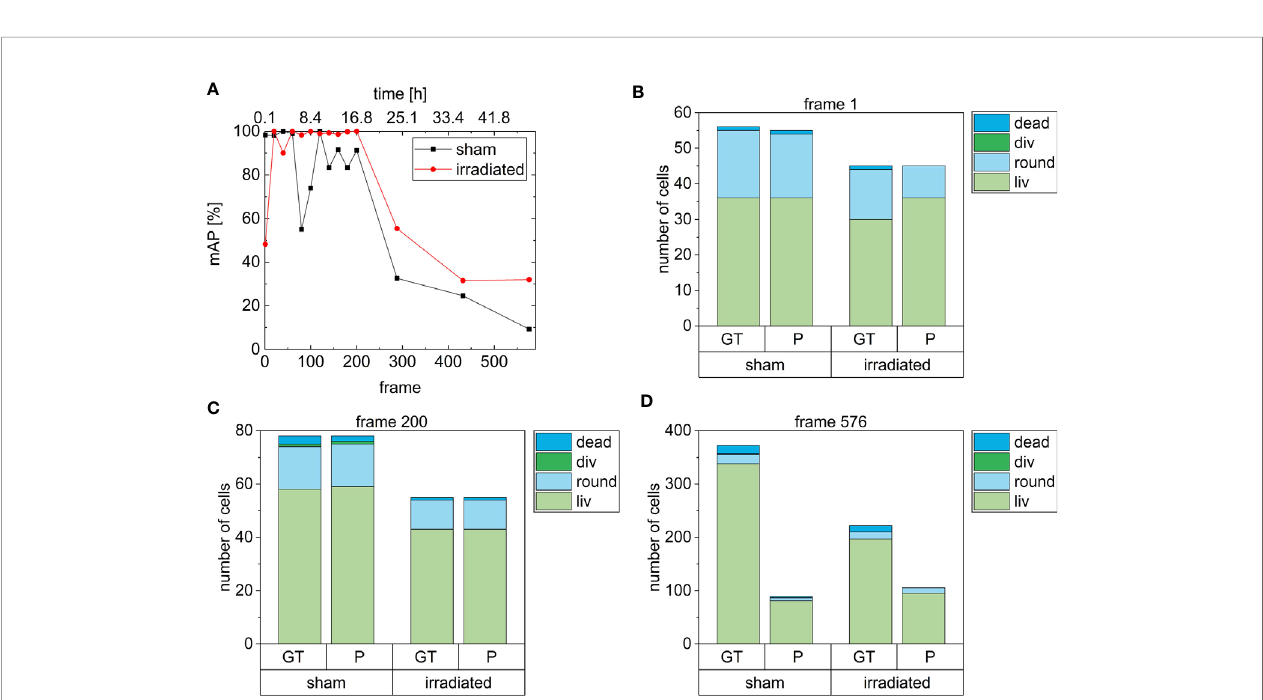
FIGURE 5 | The ground truth boxes are shown in (A) and in (B) the boxes predicted by CeCILE. White frames label round cells, green frames living cells and orange frames dead cells. In (C) the box areas from the ground truth are depicted in green and the box areas of CeCILE in magenta. The overlap of the boxes from CeCILE and the ground truth is shown as white